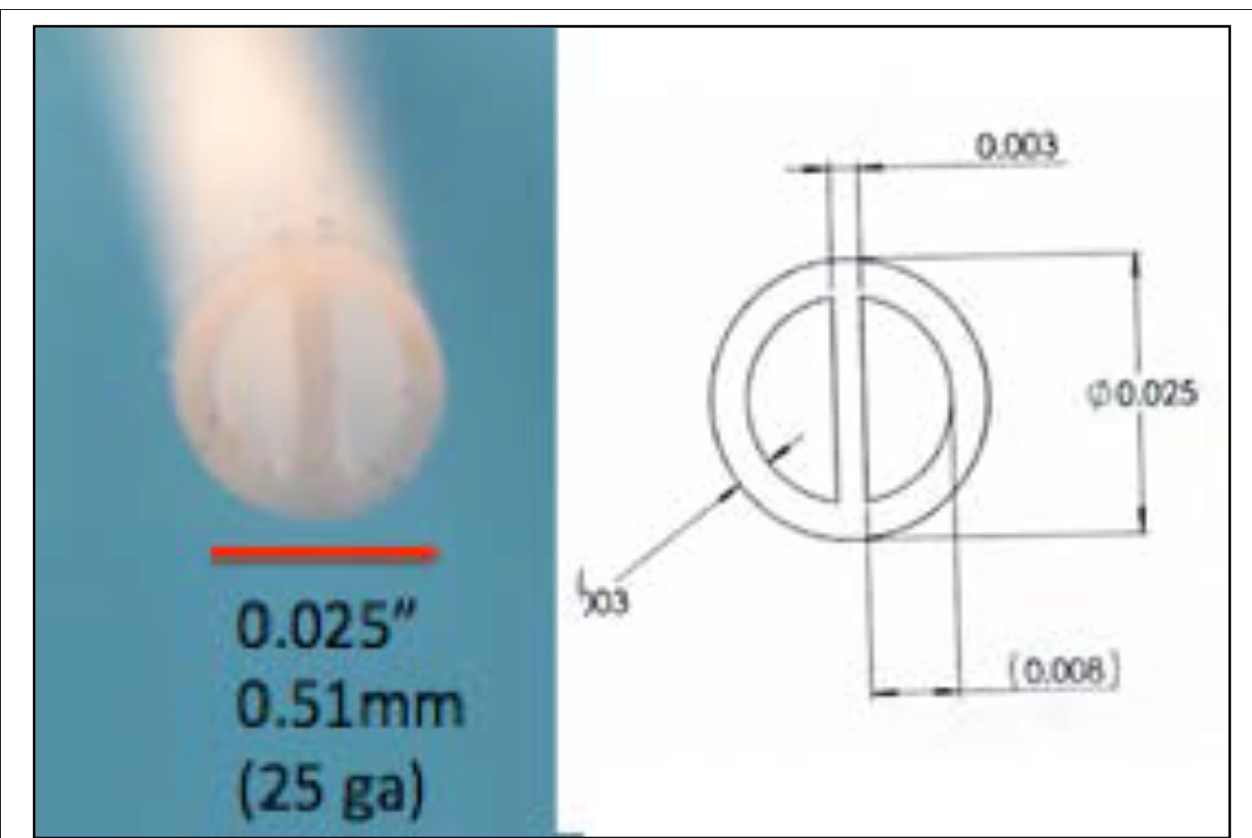
FIGURE 10 | A double lumen catheter (Polyurethane) for intrathecal